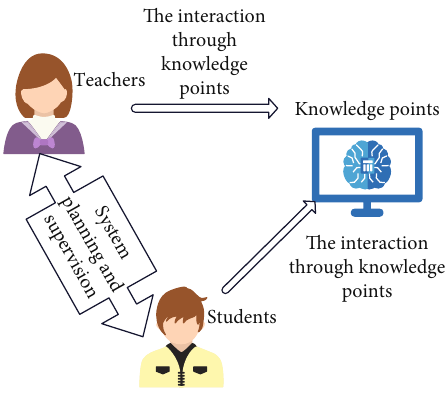
Figure 6: Immersive learning system.